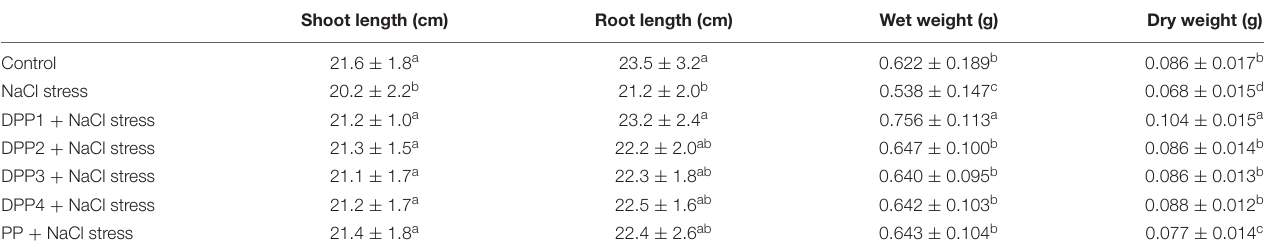
Values are mean ± SD of 30 replicates. Different letters indicate significant differences at P < 0.05.